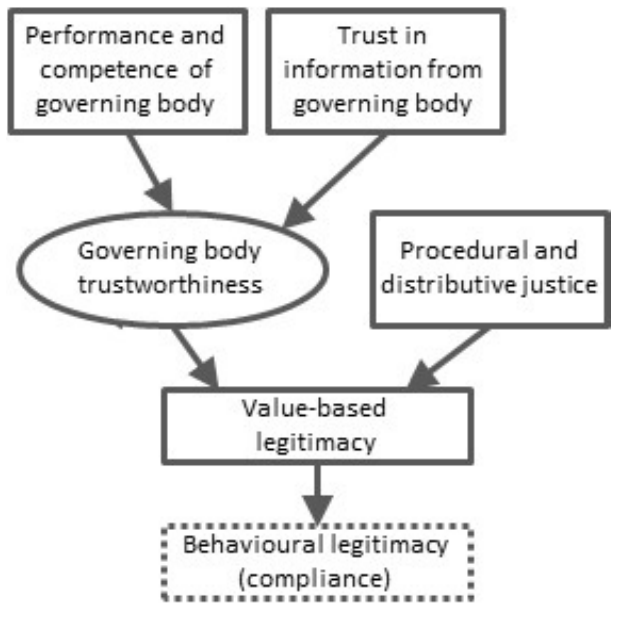
Fig. 1. Conceptual framework illustrating preconditions for legitimacy (adapted from Levi et al. 2009). Dashed box indicates components not included in this